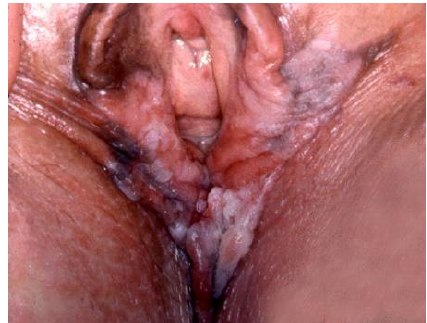
Figure 2. Biopsy-confirmed HSIL (after the application of acetic acid), with microinvasive cancer found after excision. Large lesions and/or multicentric lesions require multiple biopsies.